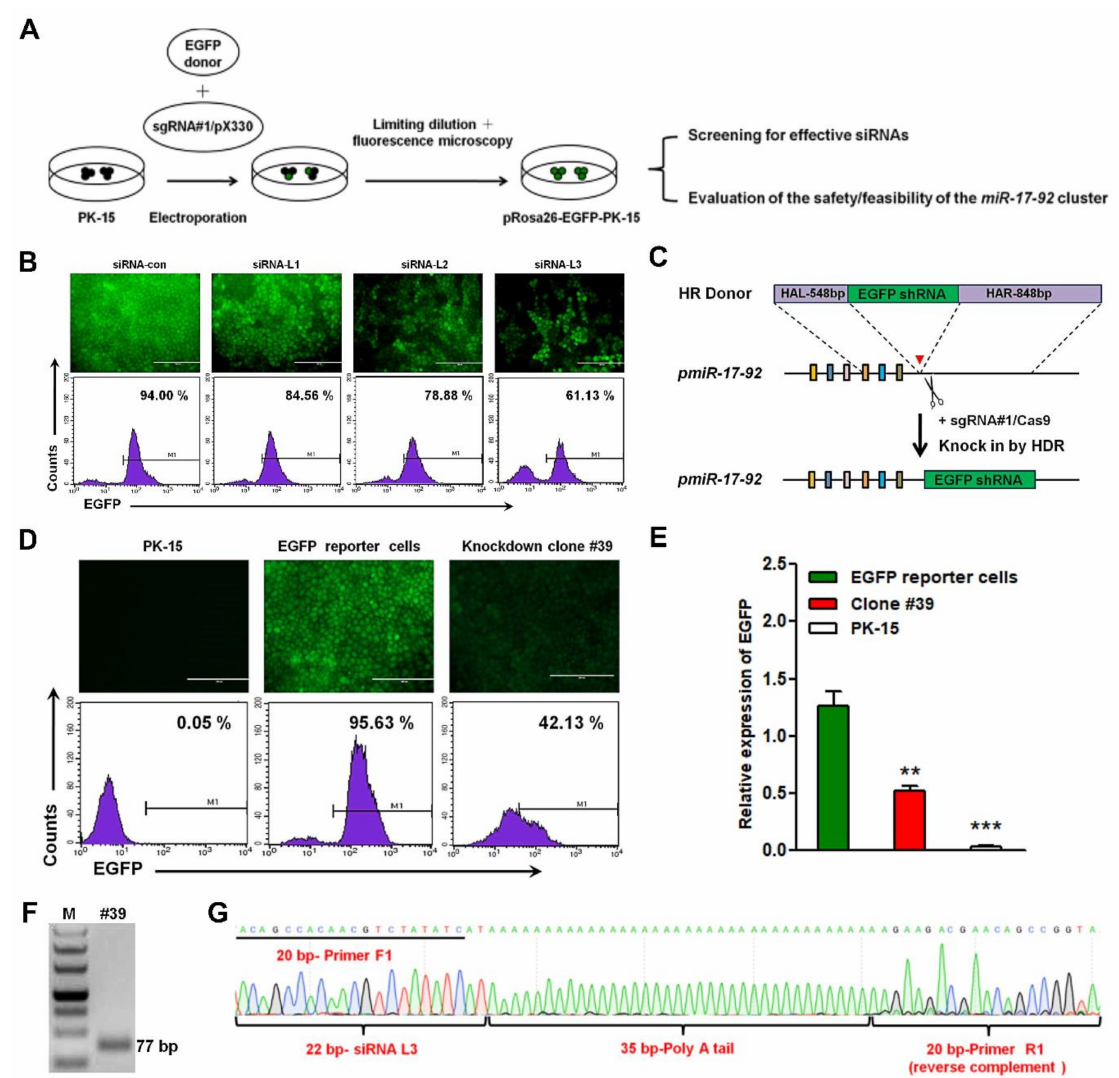
Figure 3. Construction and application of EGFP reporter cell lines via a CRISPR/Cas9 system.